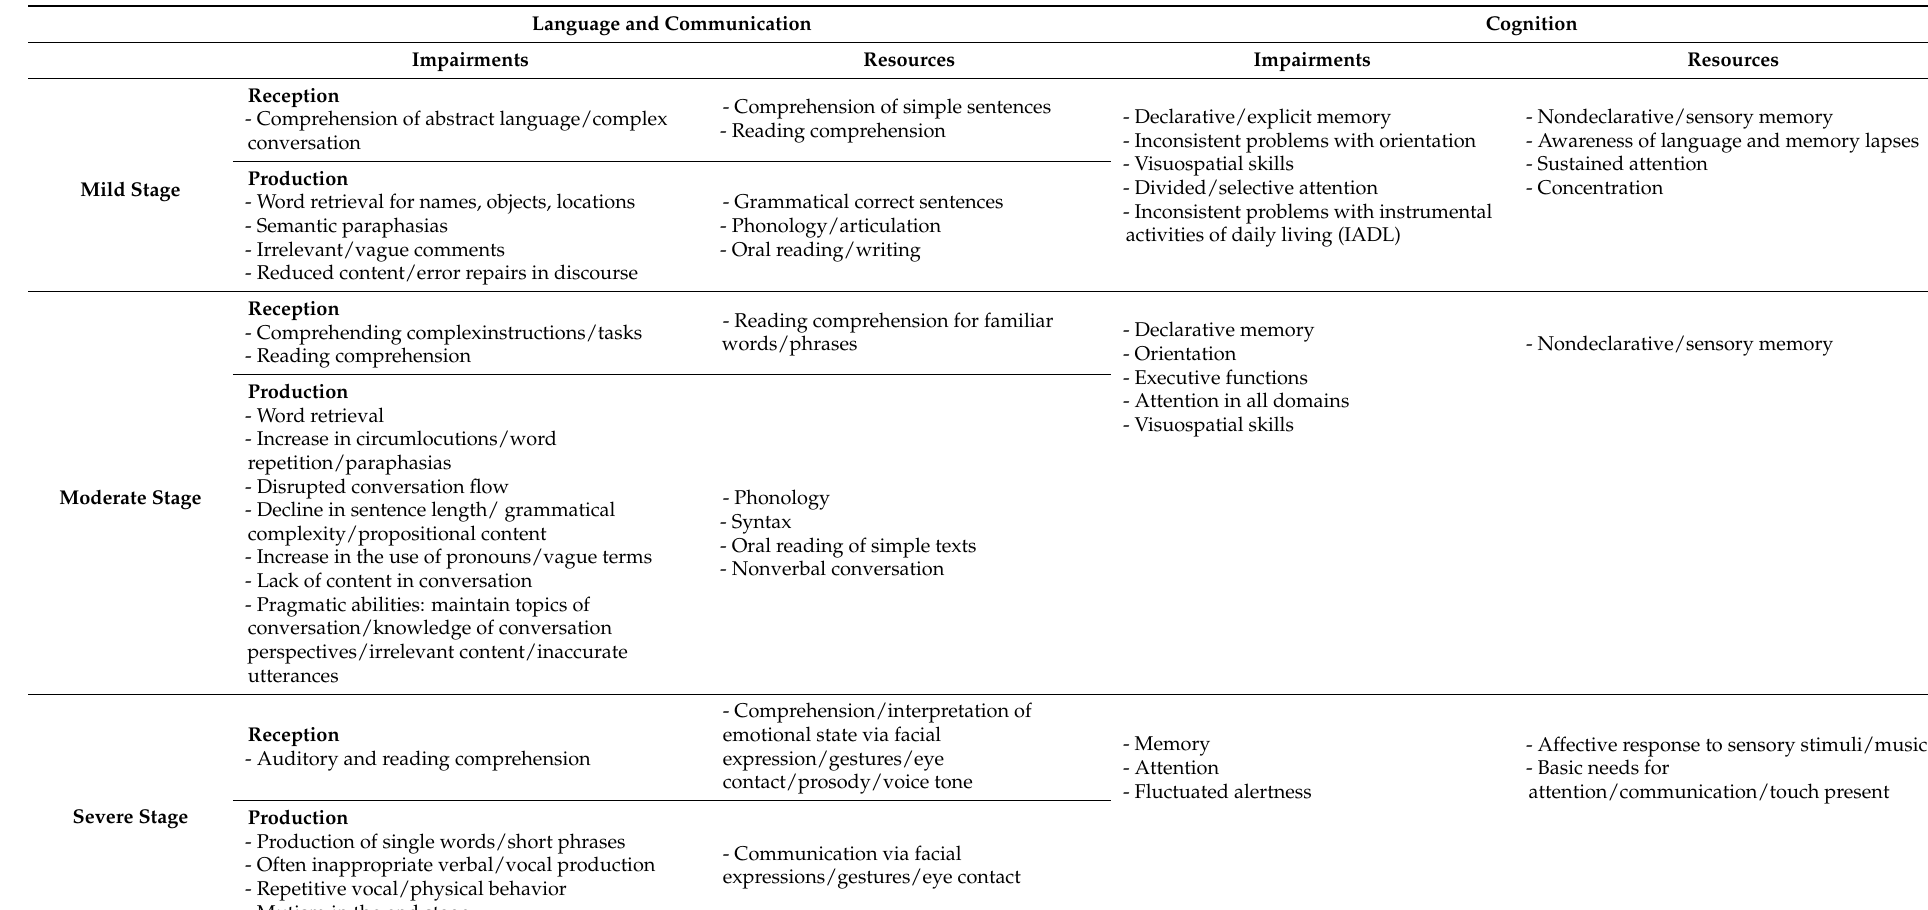
Table 2. Characteristics of cognitive language and communication difficulties in Alzheimer’s disease